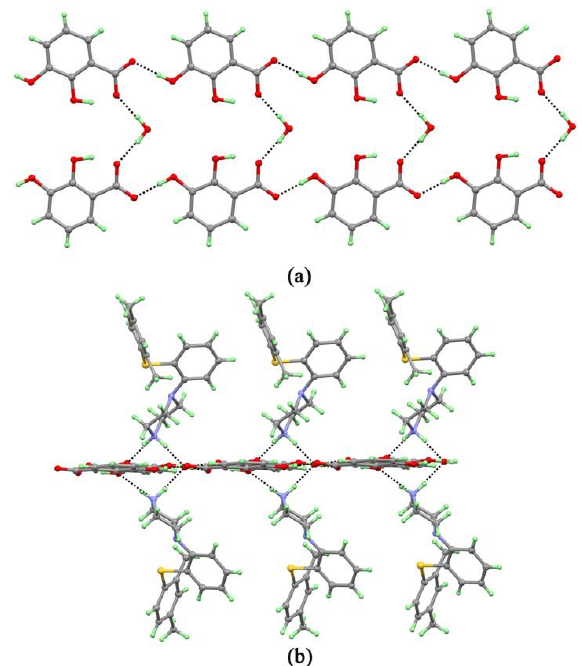
Figure 1. ( a ) Two 23BA anions and one water molecule form a two-dimension plane structure along the crystallographic b-axis through O4 − H4 ··· O1 and O5 − H5A ··· O2 hydrogen bonds; ( b ) the sandwich 3D structure of the VOT-23BA-H 2 O salt.